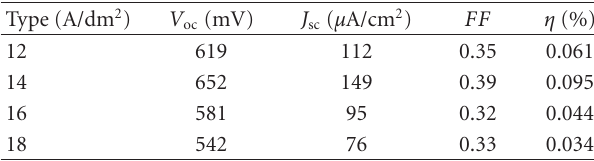
Table 1: Results from I–V characteristics of TiO 2 electrodes pre- pared at di ff erent current